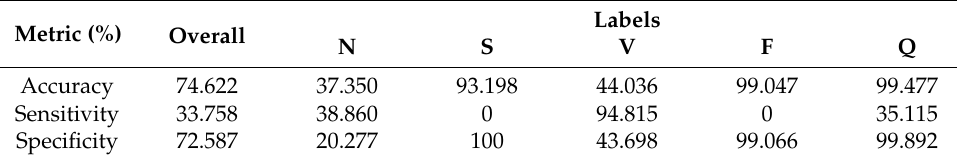
Table 10. Performance metrics of baseline model on single-lead ECG signals.